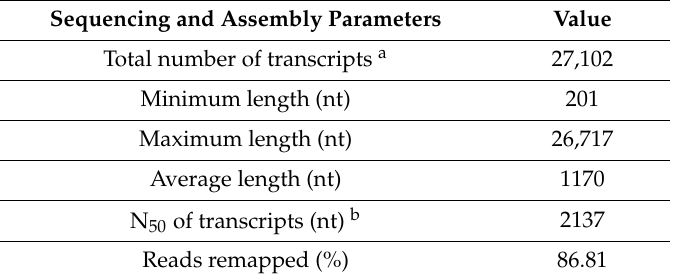
Table 4. Overview of the de novo transcriptome assembly of H. illucens